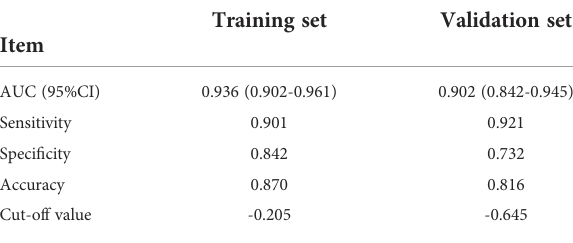
TABLE 7 Predictive performance of based on internal and external validation.